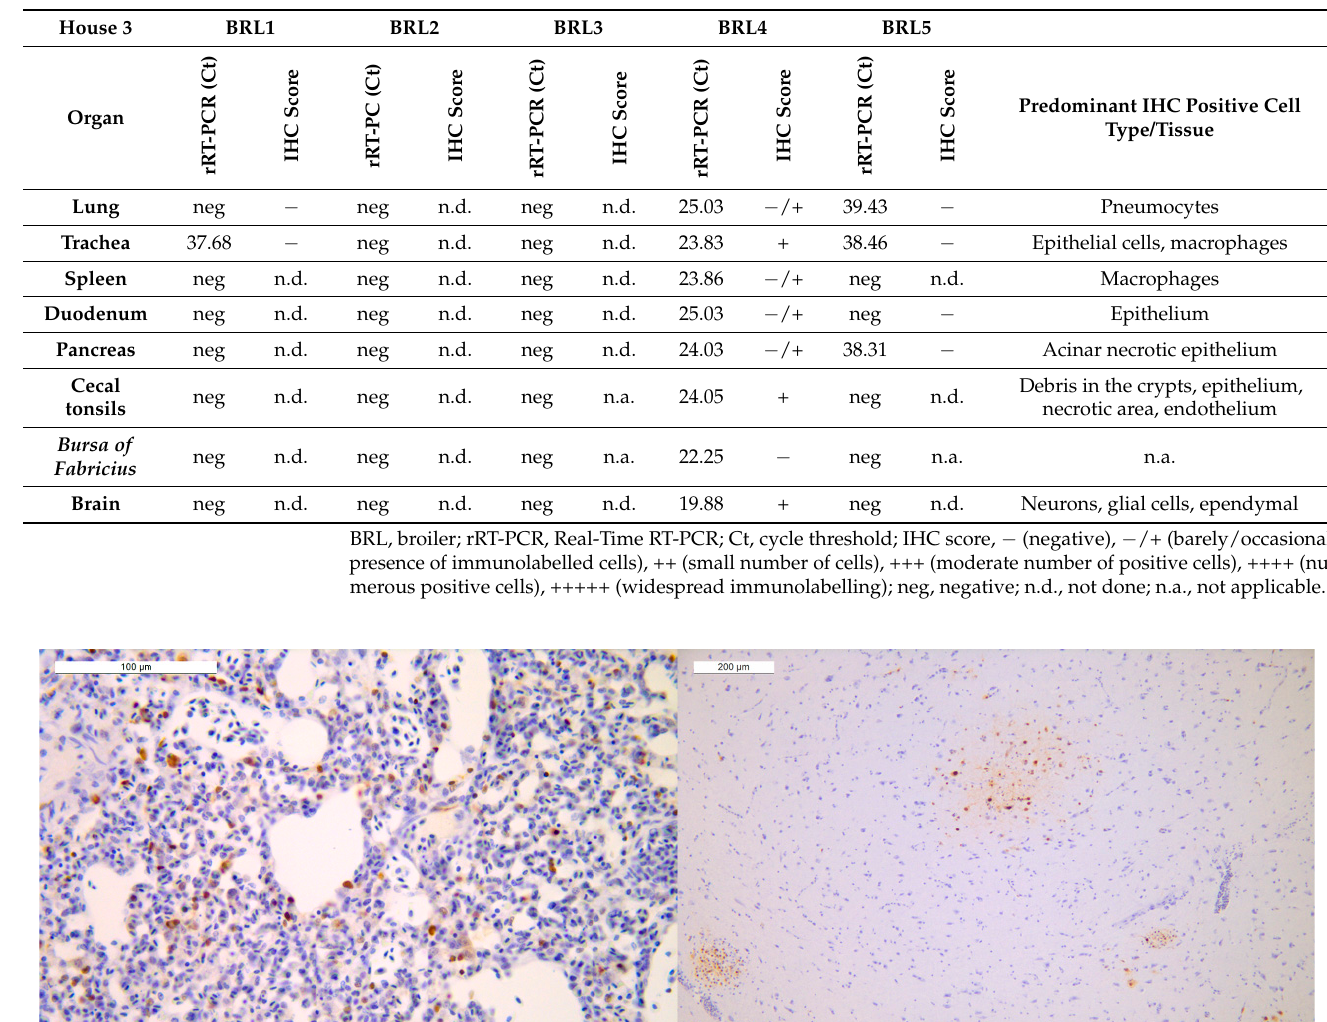
Table 3. AIV rRT-PCR (Ct) results and IHC score of organs collected from dead birds of house 3.